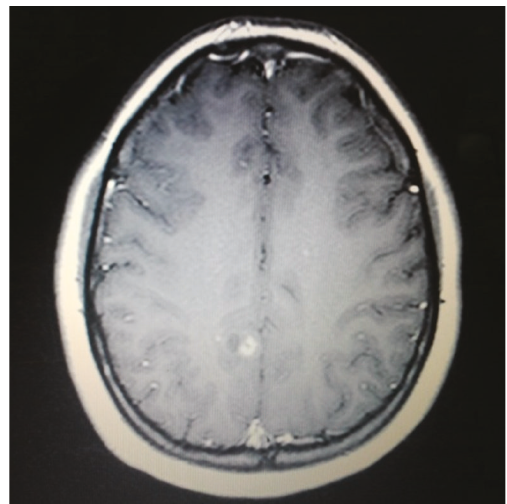
Figure 3: Pelvic MRI: the right adnexal